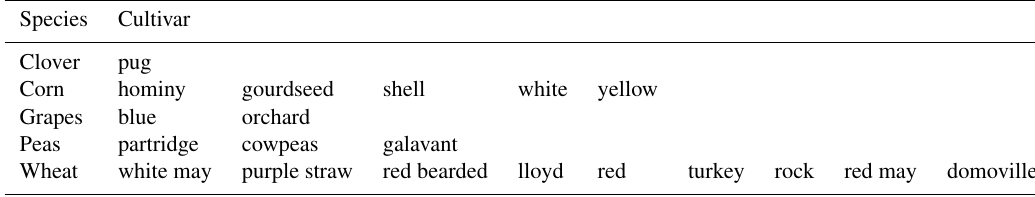
Table 4. Cultivars found in the Shirley Plantation document. Species Cultivar Clover pug Corn hominy gourdseed shell white yellow Grapes blue orchard Peas partridge cowpeas galavant Wheat white may purple straw red bearded lloyd red rock red